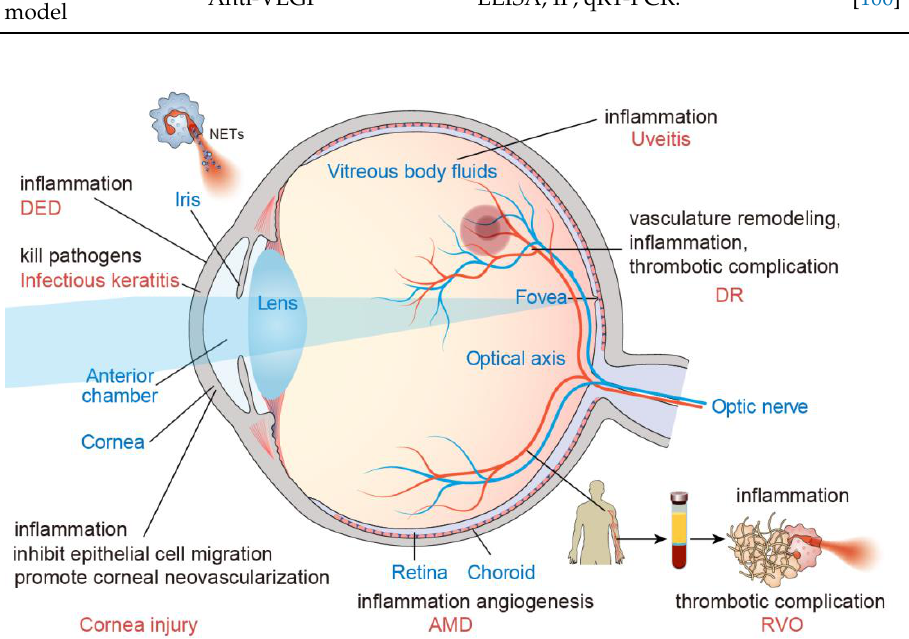
Figure 2. The localization and mechanisms of NETs in ocular diseases were shown.